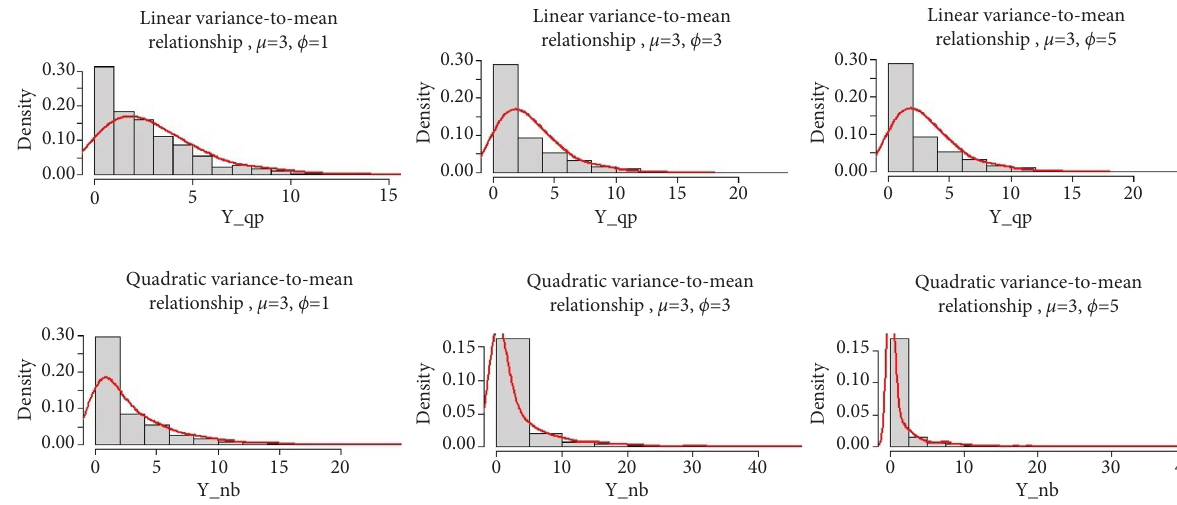
Figure 1: Histograms and density plots of some randomly generated overdispersed outcomes. Table 1: Average tick counts on two local goat